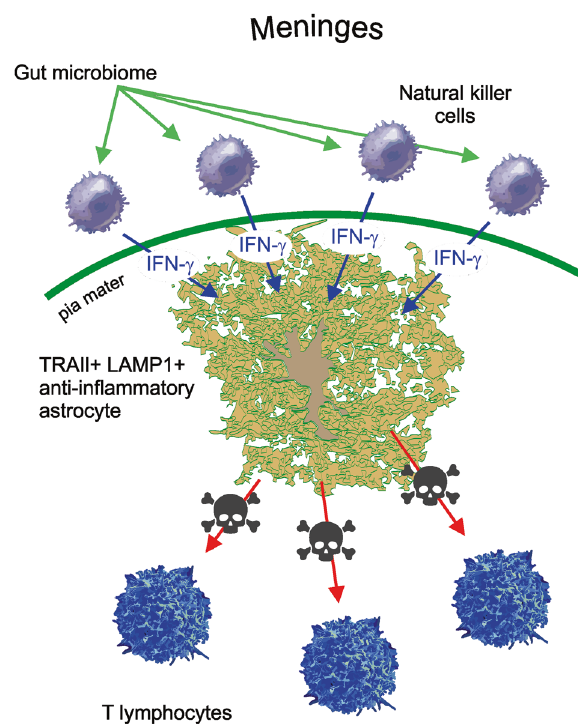
Fig. 1 Anti-in fl ammatory astrocytes. The subpopulation of anti- in fl ammatory astrocytes is present in the spinal cord of mice and possibly of humans. 5 These astrocytes speci fi cally express the lysosomal associated protein 1 (LAMP1) and the death receptor ligand TRAIL; the latter after being released activate death receptors on T lymphocytes instigating their apoptosis. Expression of TRAIL in astrocytes